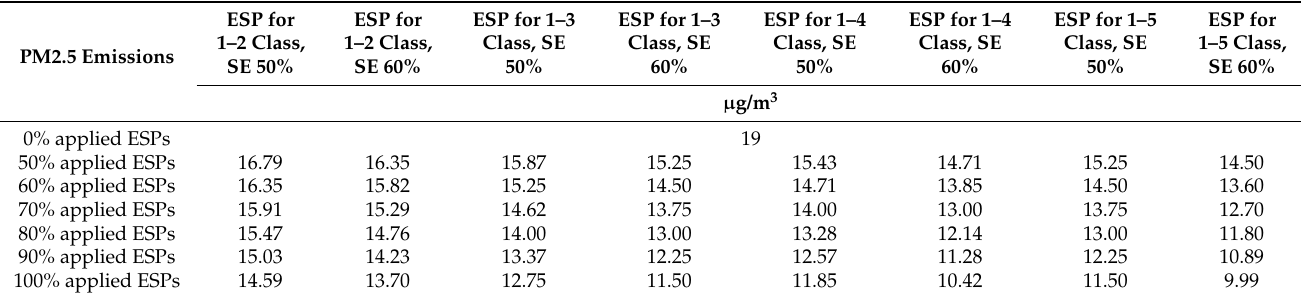
Table 4. Average annual PM2.5 concentrations in the air of the model